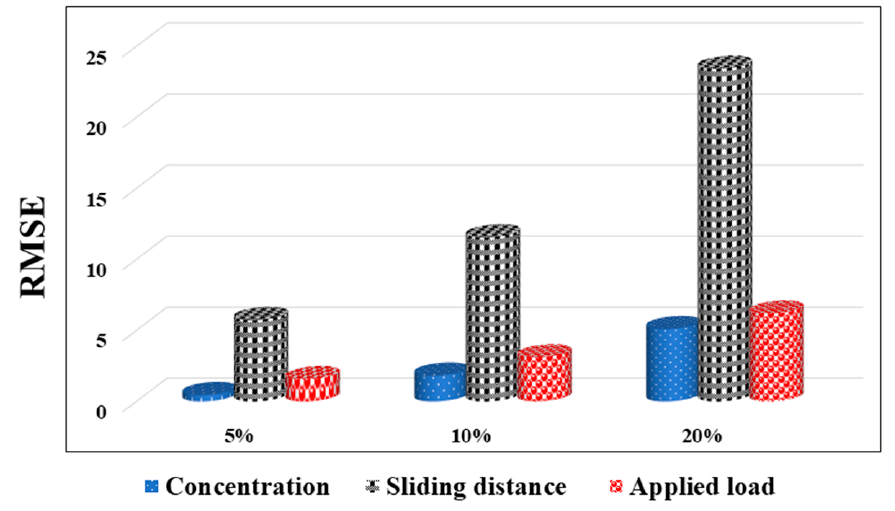
Figure 5. Sensitivity analysis of the practical